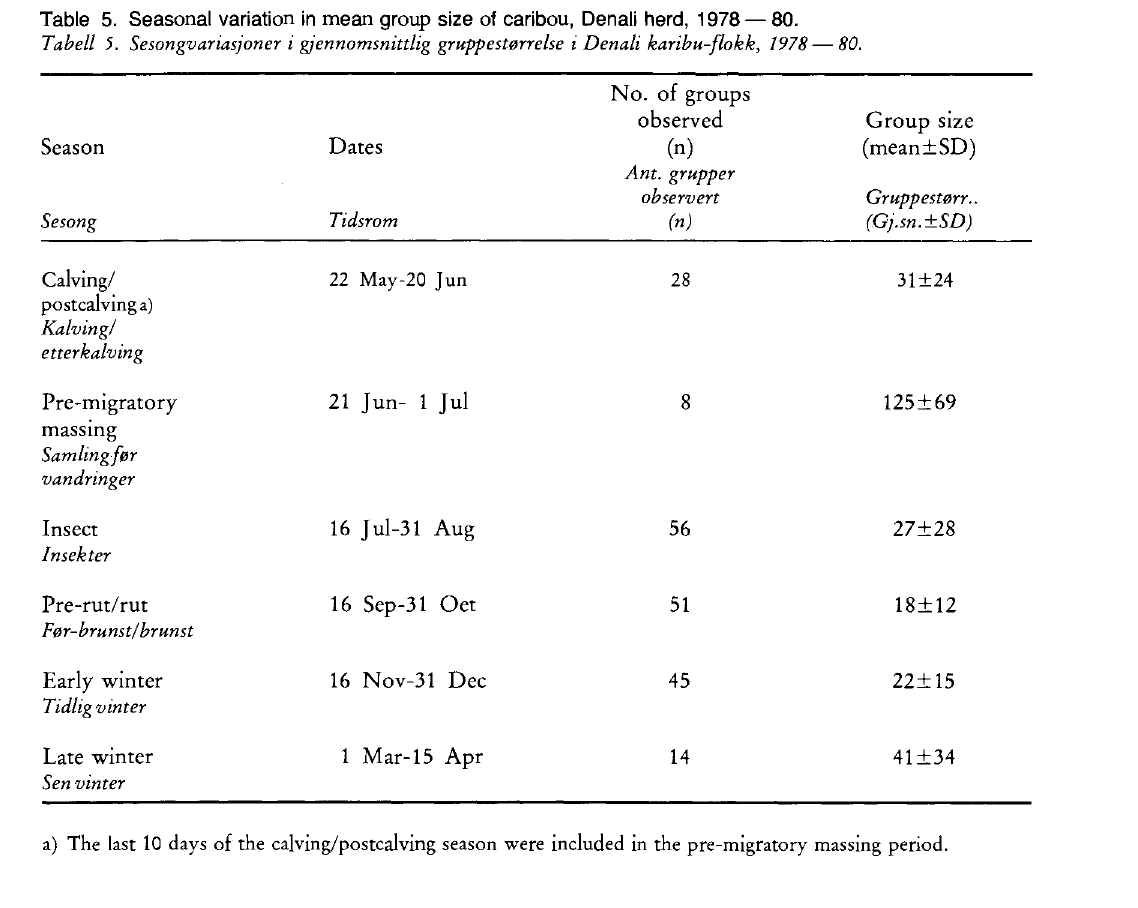
Table 5. Seasonal variation in mean group size of caribou, Denali herd, 1978 —